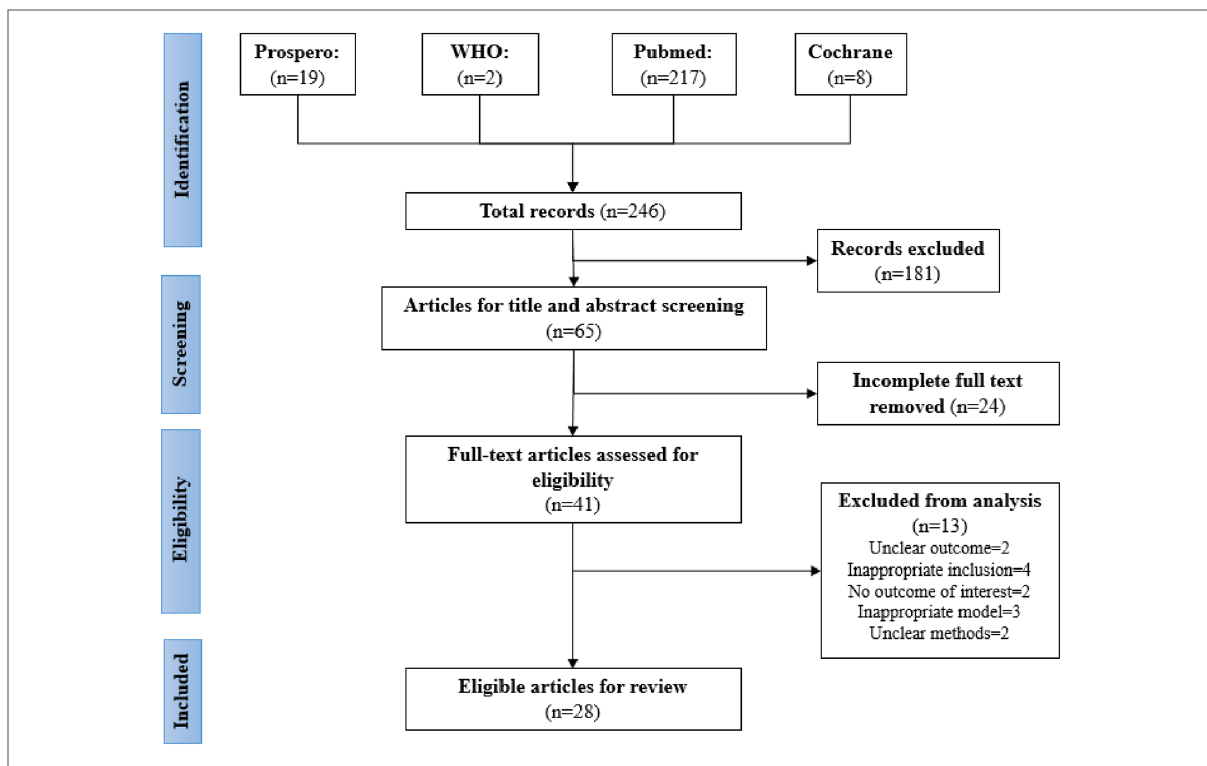
Figure 1 . Out of the 246 articles selected from four databases, 181 duplicate articles were excluded. Then, during screening, approximately 24 articles that had incomplete full text